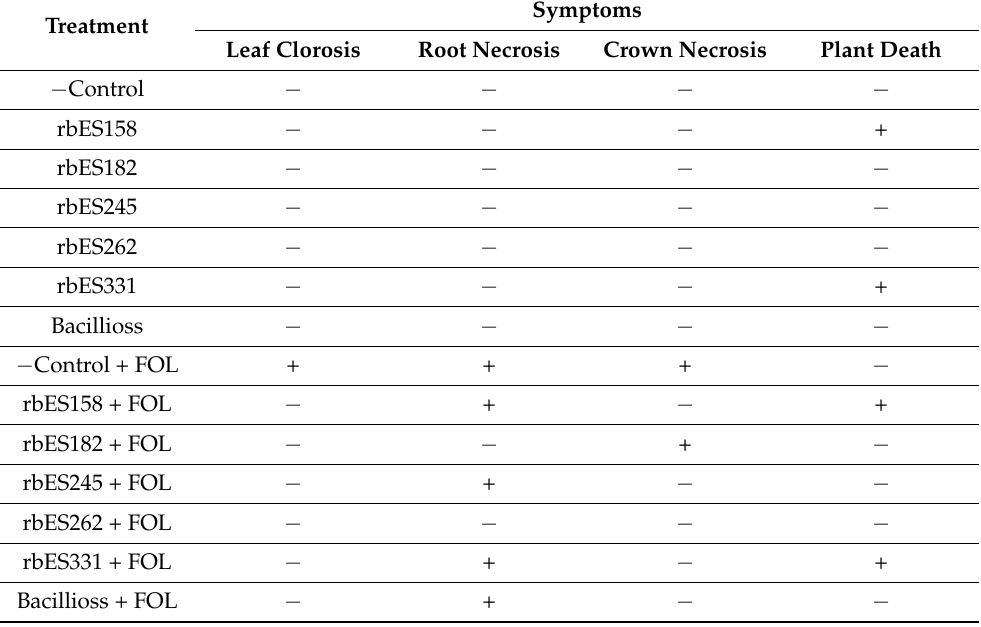
Table 2. Fusarium wilt symptoms observed in plants from the in vivo pathogen suppression assays. Treatment Leaf